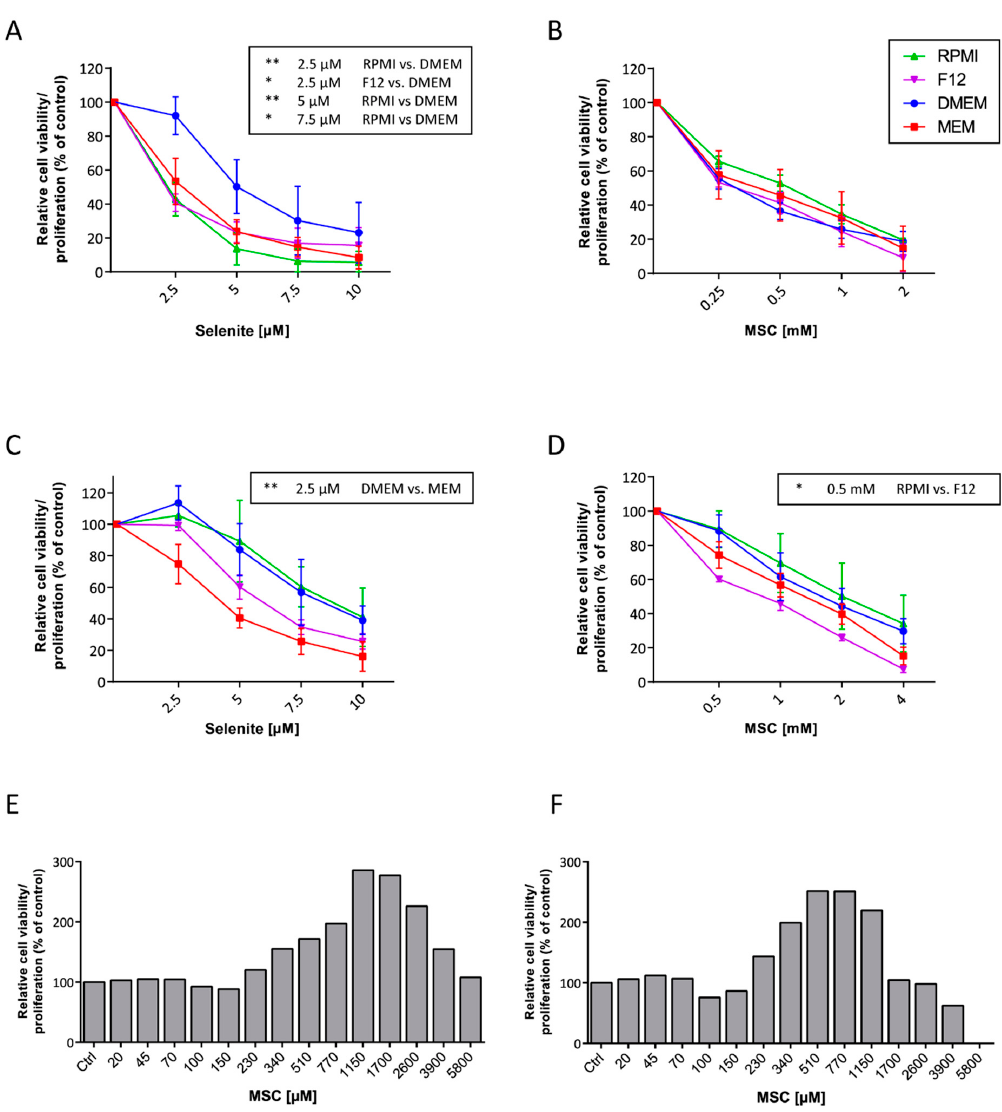
Figure 1. Selenite and Se-methylselenocysteine (MSC) toxicity. Effect of the different media on selenite and MSC toxicity determined by measuring ATP production and calculated as viability (%). ( A ) and ( B ) A549 cells, ( C ) and ( D ) HepG2 cells. Data is presented as mean +/ − standard deviation. Statistical analysis was performed using the Kruskall–Wallis test. (* p < 0.05 and ** p < 0.01) ( n = 3–4, all experiments were done in triplicates). Toxicity evaluation of MSC on HepG2 using WST-1 at ( E ) 24 h and ( F ) 48 h ( n =